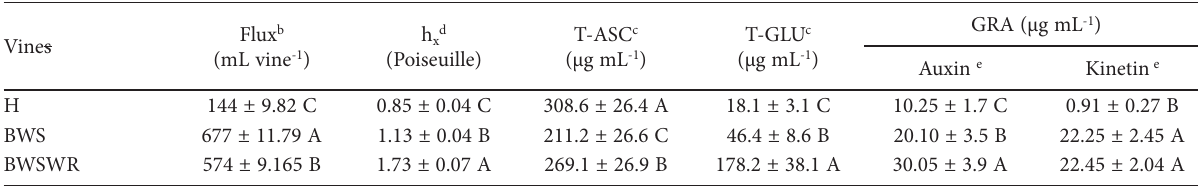
Table 2. Flux, viscosity coefficient (h x ), concentrations of total ascorbate (T-ASC), glutathione (T-GLU), and growth regulator activity (GRA) of bleeding xylem sap collected from ‘Italia’ vines a that were healthy (H), or had brown wood streaking (BWS) or brown wood- streaking and white rot